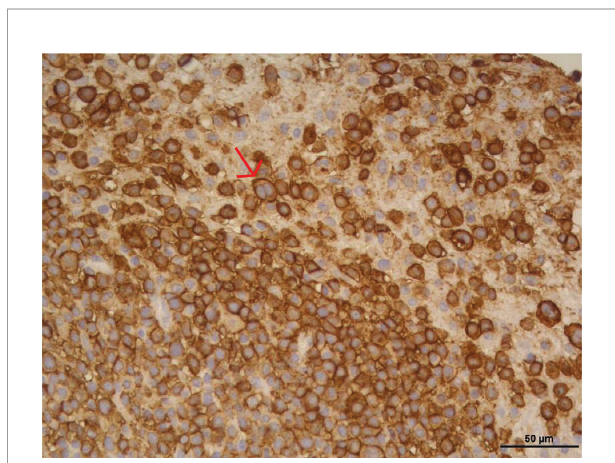
FIGURE 2 | The tumor derived from a TNBC patient implanted in a PDX was a B-cell lymphocytic tumor (XABCL). CD20 immunohistochemical stain in the histological section revealed that most of the cells were CD20+ B cells. Cells with a bilobed nucleus, reminding of the Reed – Sternberg cells associated with Hodgkin ’ s lymphoma, were observed (pointed with a red arrow).